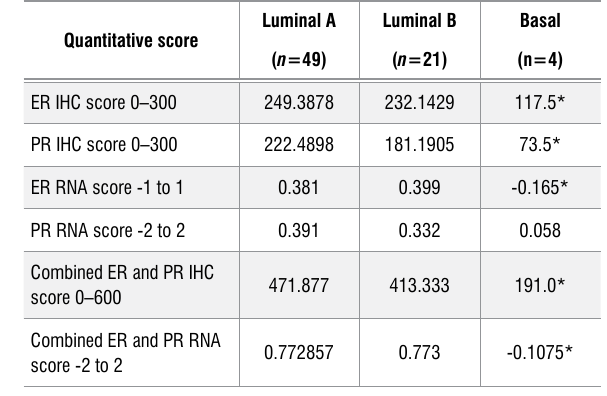
Table 2: Mean values of oestrogen receptor (ER), progesterone receptor (PR) and combined scores for immunohistochemistry (IHC) and RNA in relation to tumour subtype